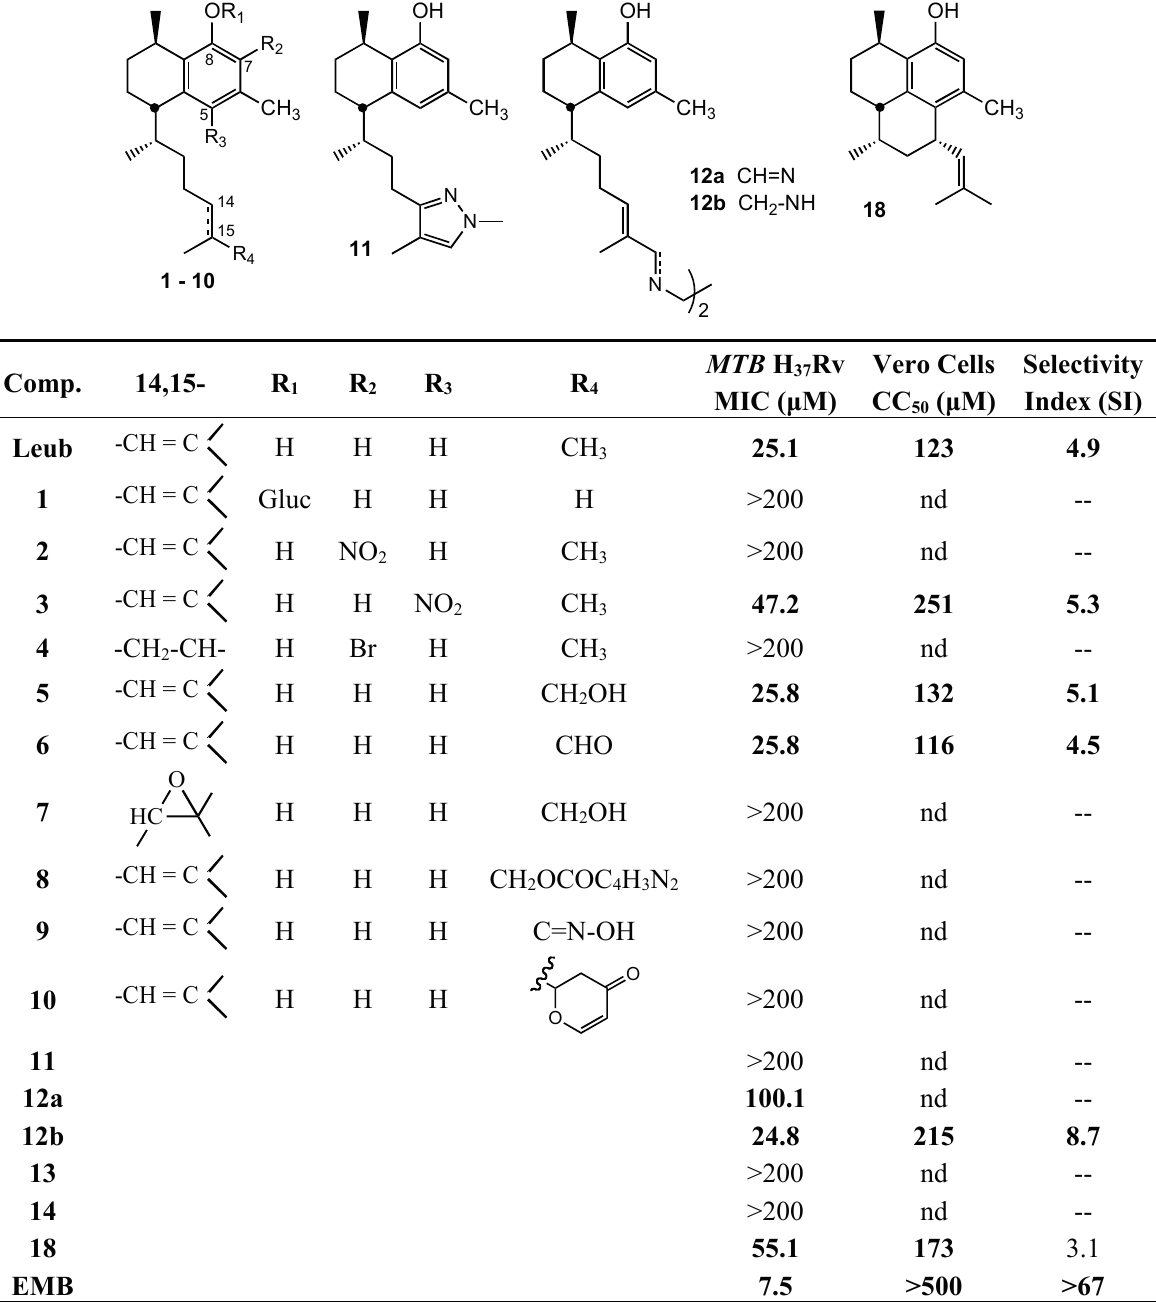
Table 1. Antimycobacterial activity, cytotoxicity and selectivity index of leubethanol derivatives.